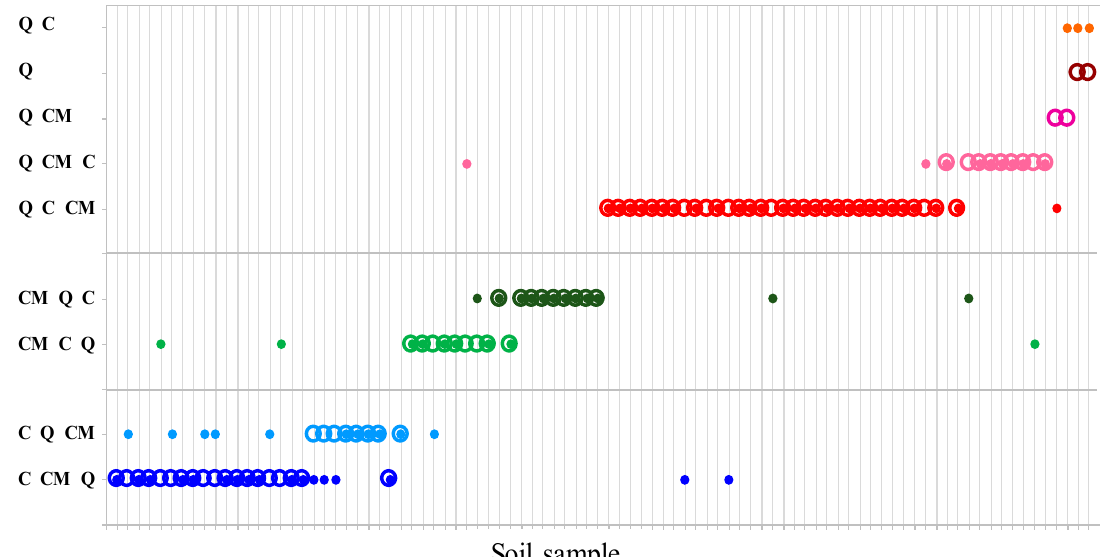
Figure 9. Mineralogy (from more to less abundant, y -axis) of each soil sample; spectral-based classification (empty circles) and XRD analysis results (filled circles).